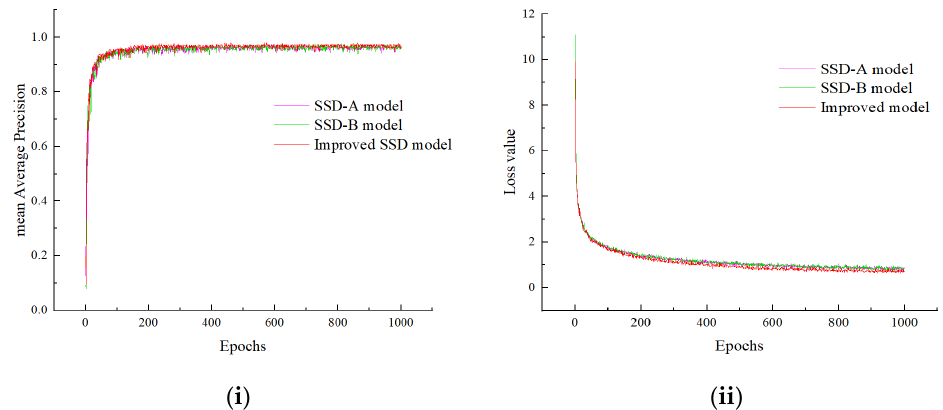
Figure 11. The change curve in the comparison experiment of the improved Peleenet network. ( i ) Mean average precision; ( ii ) Loss value.